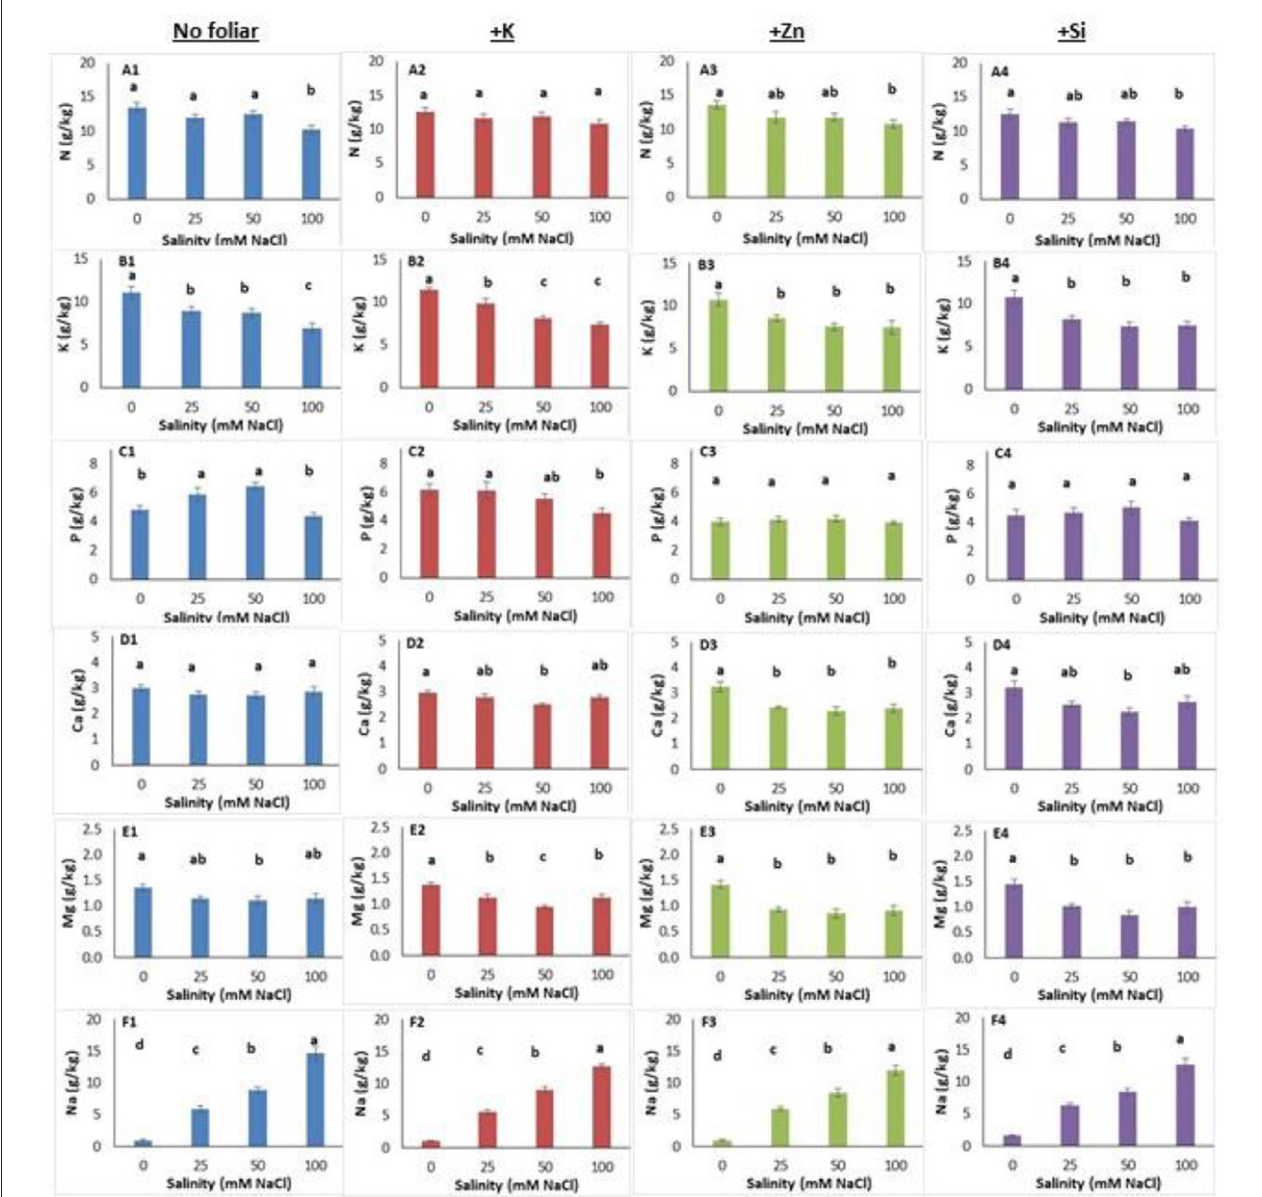
FIGURE 3 | Lavender leaf analysis (macronutrient) of plants grown hydroponically in perlite under different salinity levels (0–25–50–100 mM NaCl) and foliar applications (no foliar, K, Zn and Si). Sub-figures (A–F) referring to different macronutrients and numbering (1–4) referring to the no foliar, K, Zn and Si, respectively. Significant differences ( P < 0.05) among treatments are indicated by different letters. Error bars show SE ( n = 6).